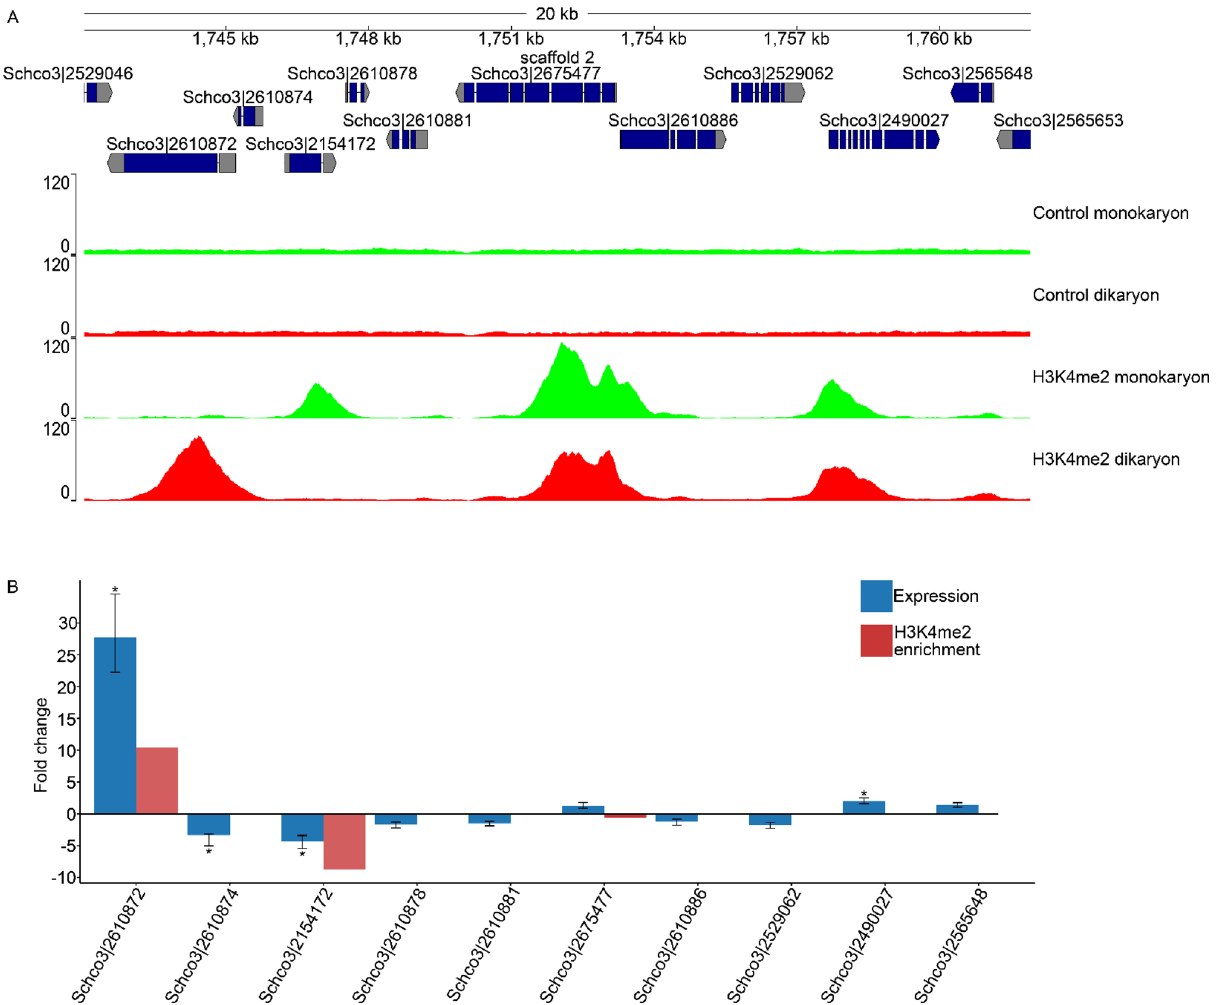
Figure 3. Histone H3 K4 dimethylation distribution and expression during monokaryotic and dikaryotic development on scaffold 2. ( A ) Overview of read-depth from both the control samples and the H3K4me2 ChIP samples on a representative part of the genome (scaffold 2: 1,742,000–1,762,000). The controls show a homogenous read depth across the genome, while ChIP resulted in enrichment around the translation initiation site (TIS) of genes. Most sites of enrichment were found during both monokaryotic and dikaryotic development, while some were unique to each developmental condition. ( B ) Change in expression (blue) and H3K4me2 enrichment (red) of 10 genes on scaffold 2. Positive numbers indicate higher expression and enrichment during dikaryotic growth, while negative numbers indicate higher expression and enrichment during monokaryotic growth. Asterisks (*) indicate a > twofold absolute change in expression.